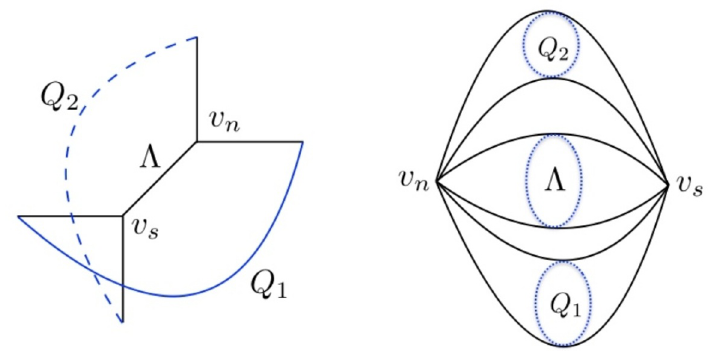
Figure 2 . Double compacti(cid:12)cation of the resolved conifold is a degenerate genus two curve. The K(cid:127)ahler parameters of three rational curves P 1 match three moduli of genus two curves.